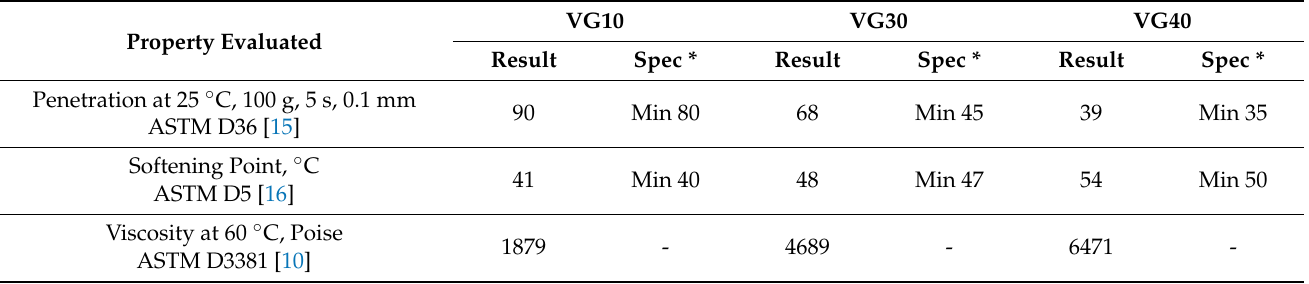
Table 4. Results of Tests Conducted on Unmodified Binders . Table 3. Results of Tests Conducted on Unmodified Binders.